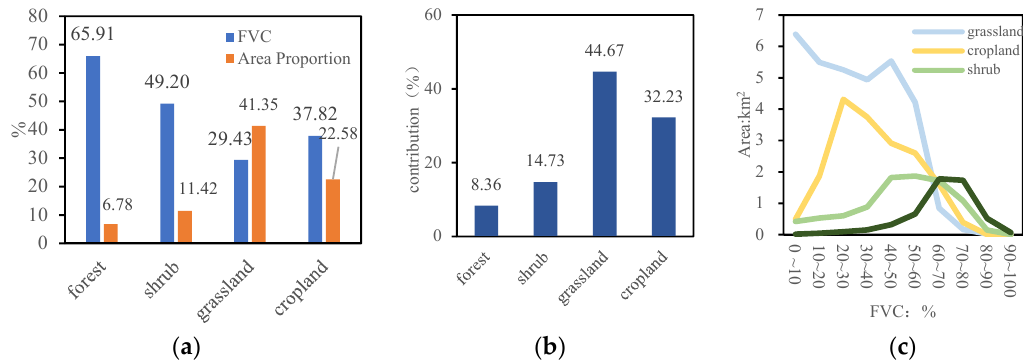
Figure 8. ( a ) The FVC and area proportion of different vegetation types. ( b ) The contribution of different vegetation types. ( c ) Area proportion of different grades of different vegetation types.